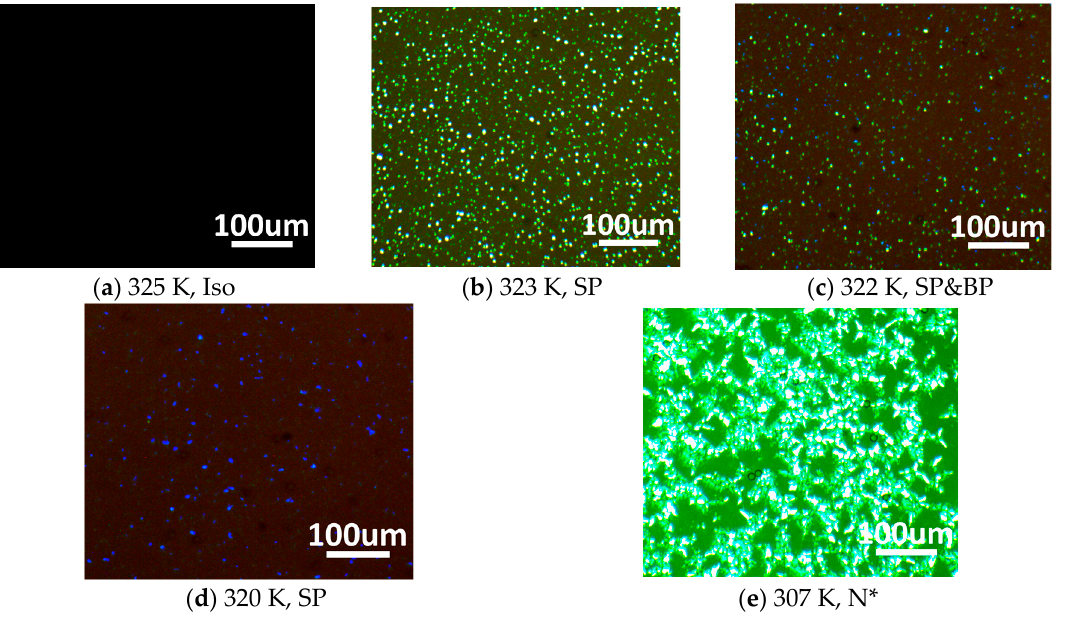
Figure 1. Reflective photographs under a POM of the LC mixture at different temperatures: ( a ) isotropic phase; ( b ) sphere phase; ( c ) sphere phase and blue phase; ( d ) blue phase; and ( e ) chiral nematic phase.